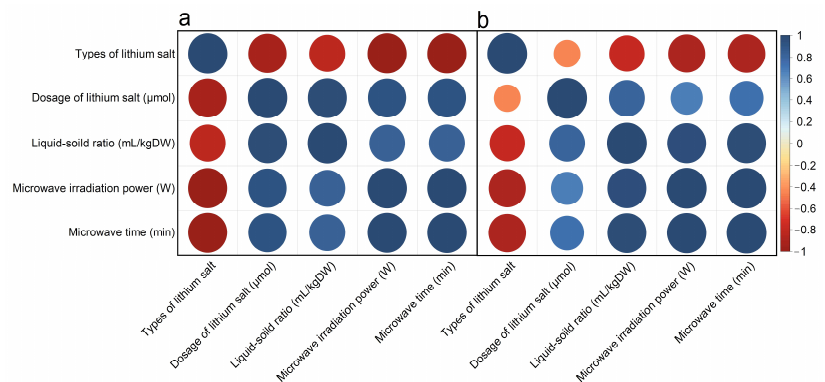
Figure 5. Correlation analysis of yield of ( a ) essential oil and ( b ) polysaccharide under different factors.